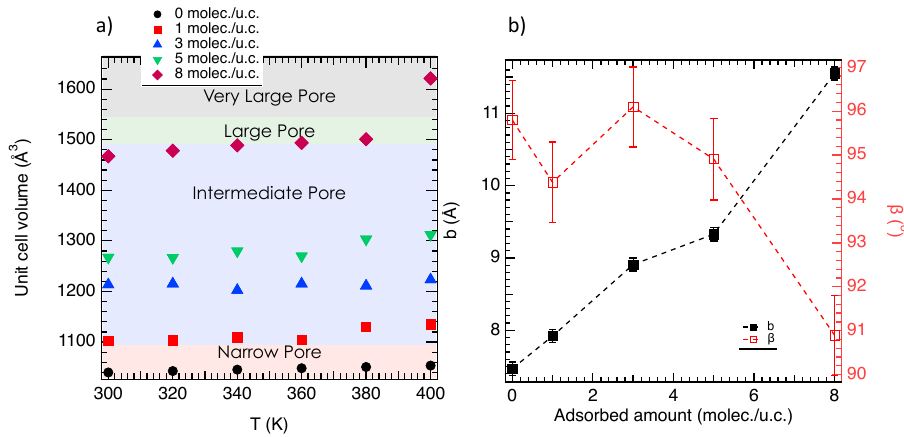
Figure 7. ( a ) Unit cell volume of the NH 2 -MIL53(Al) as a function of the temperatures and adsorbed amount; ( b ) Unit cell parameters (b and β ) as a function of the adsorbed amount at 300